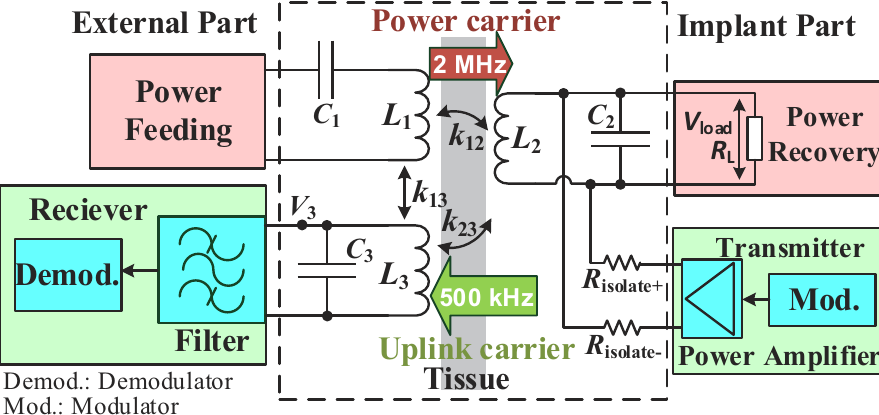
Figure 2. Block diagram of the magnetic-balanced inductive link system.